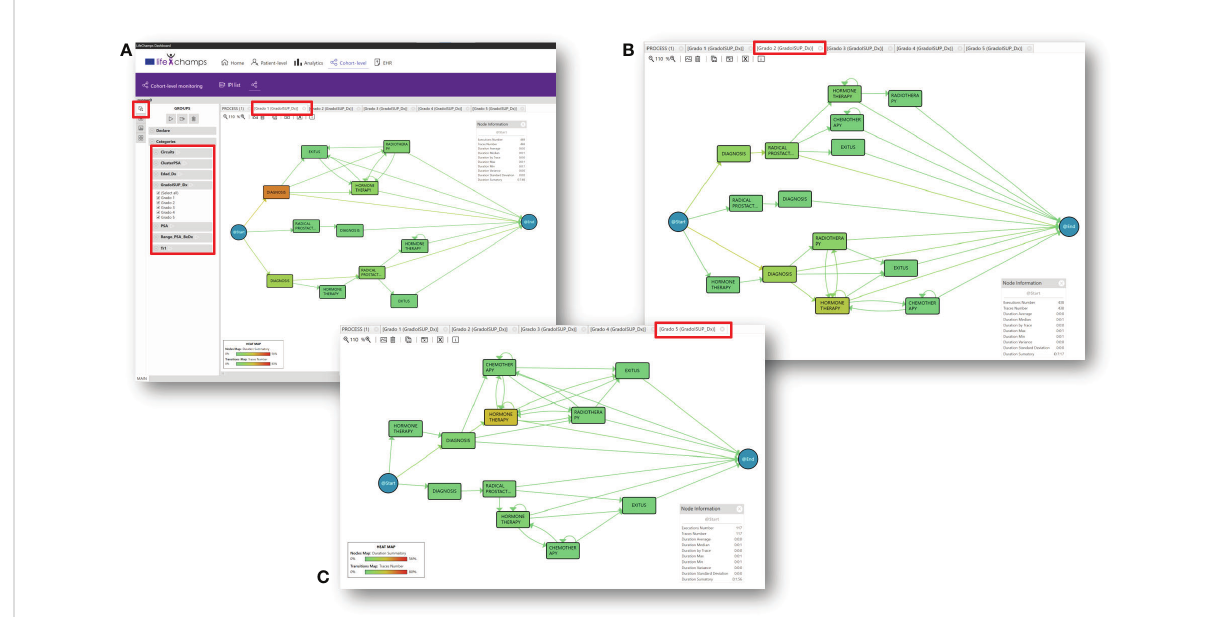
FIGURE 5 Insights. IPI with groups by Gleason Grade Groups at diagnosis for prostate cancer. (A) Gleason Grade Group 1, (B) Gleason Grade Group 2, and (C) Gleason Grade Group